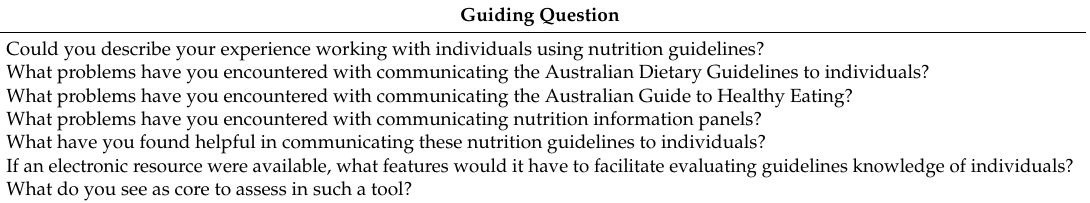
Table 1. Guiding questions for group discussion on development of an electronic tool to assess nutrition